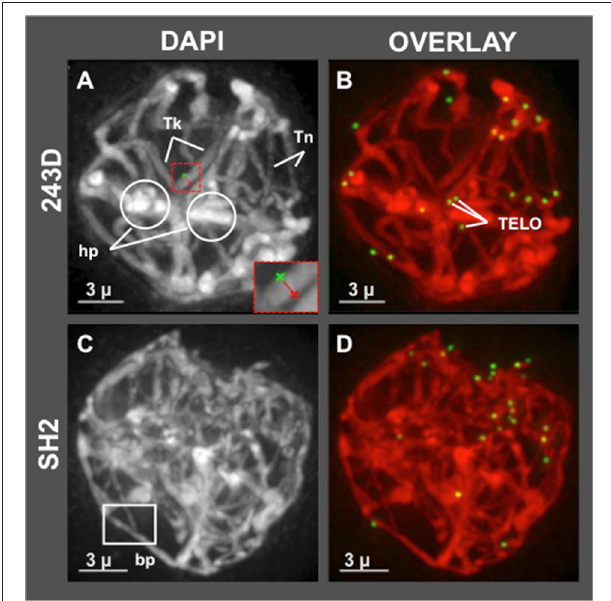
FIGURE 4 | Hop pachytene nuclei with differential chromosome fiber thickness. Hop nuclei at pachytene showing distinct areas of non-uniform chromosome fibers. Fiber widths were measured at four locations per fiber and averaged, distinguishing thick (Tk) from thin (Tn) fibers. (A,B) Pachytene (middle prophase, post-bouquet) nucleus from plant 243D also shows heteropycnotic (circled, hp) regions. Red dashed box indicates an example of measurement tool for distance across fibers. (C,D) Middle prophase nucleus (early pachytene, post-bouquet) from wild-collected var. neomexicanus , plant SH2, shows a structure resembling a synapsis branch point (bp, white box). The length of the scale bars (3 microns) is indicated.